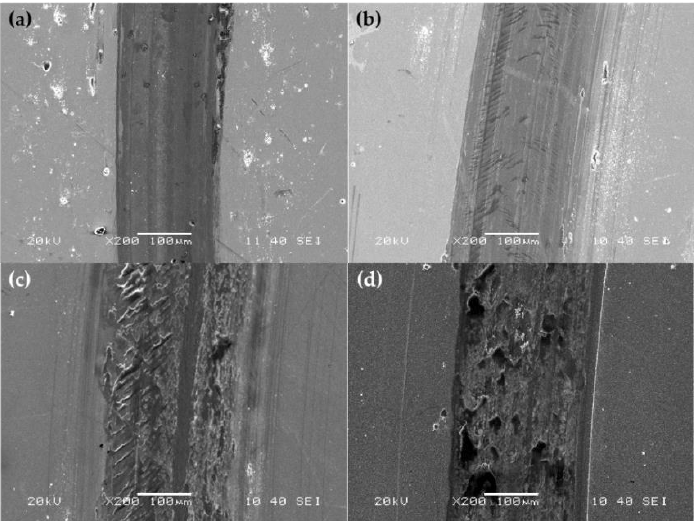
Figure 7. SEM images of the wear tracks at various testing temperatures: ( a ) 25 °C, ( b ) 200 °C, ( c ) 400 °C and ( d ) 550 °C. and ( d ) 550 ◦